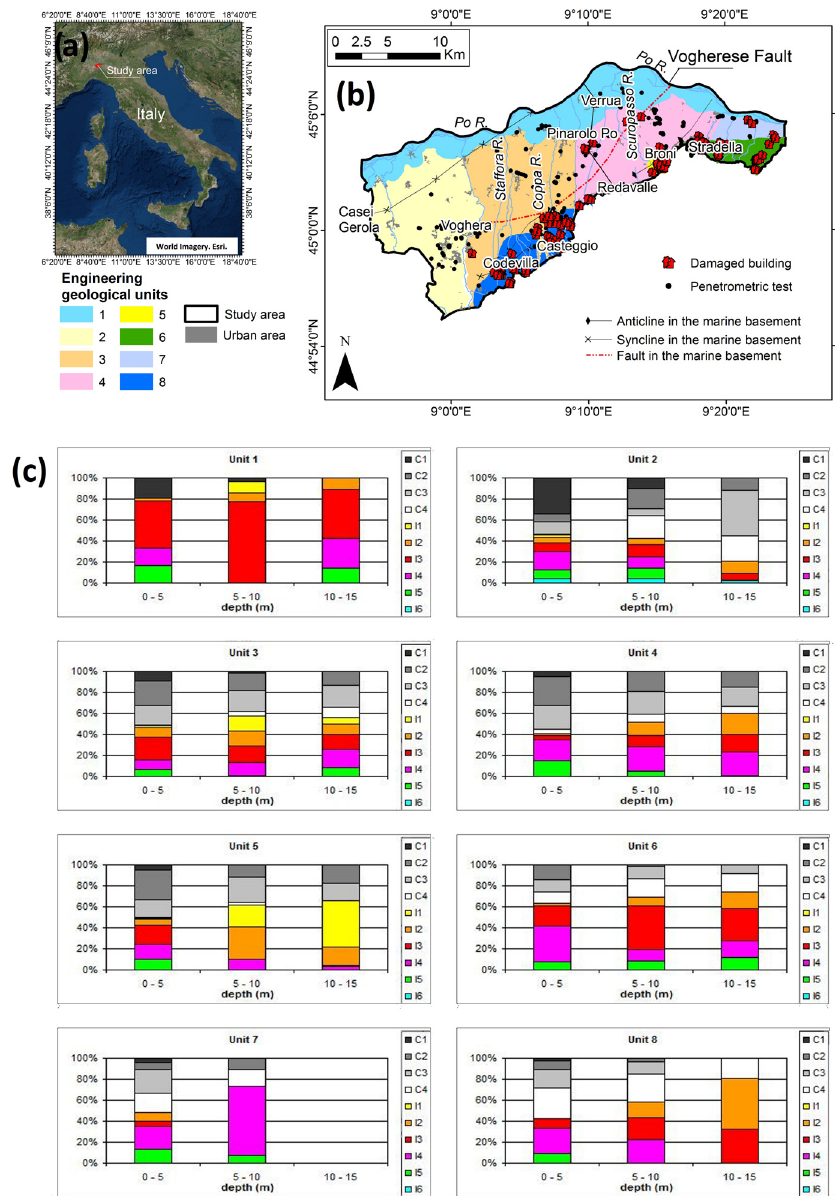
Figure 1. ( a ) Location of the study area. Sources: Esri, DigitalGlobe, Earthstar Geographics, CNES/Airbus DS, GeoEye, USDA FSA, USGS, Getmapping, Aerogrid, IGN, IGP, and the GIS User Community. ( b ) Distribution of the engineering geological units in the plain area of the Oltrepo Pavese. Damaged buildings, detected by Meisina et al. (2006) [31], are also reported. ( c ) Thickness percentage of the geotechnical classes in different depth intervals for each engineering geological unit (from Meisina et al., 2006) [31].